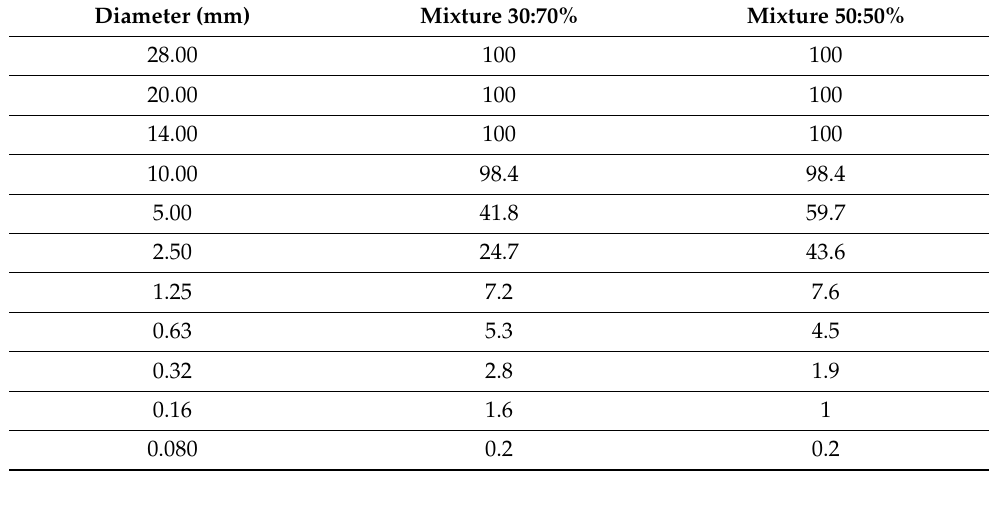
Table 2. Particle size distribution of test sands.